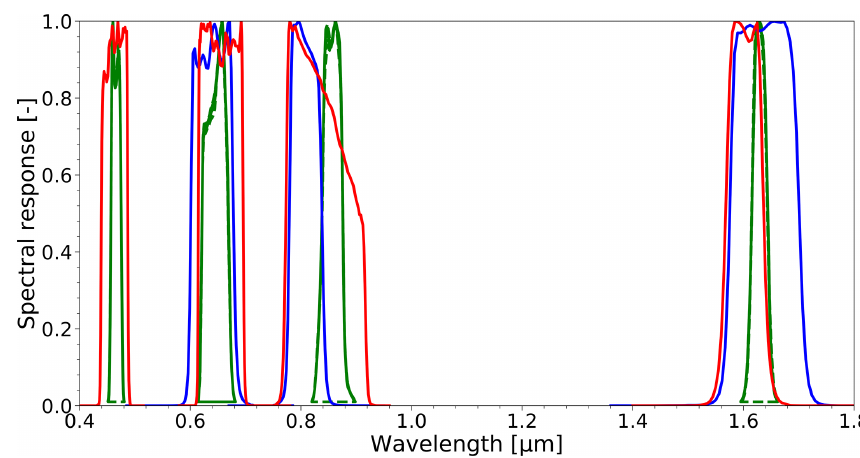
Figure 2. SEVIRI (in blue), PROBA-V (in red) and MODIS (in green) spectral responses.